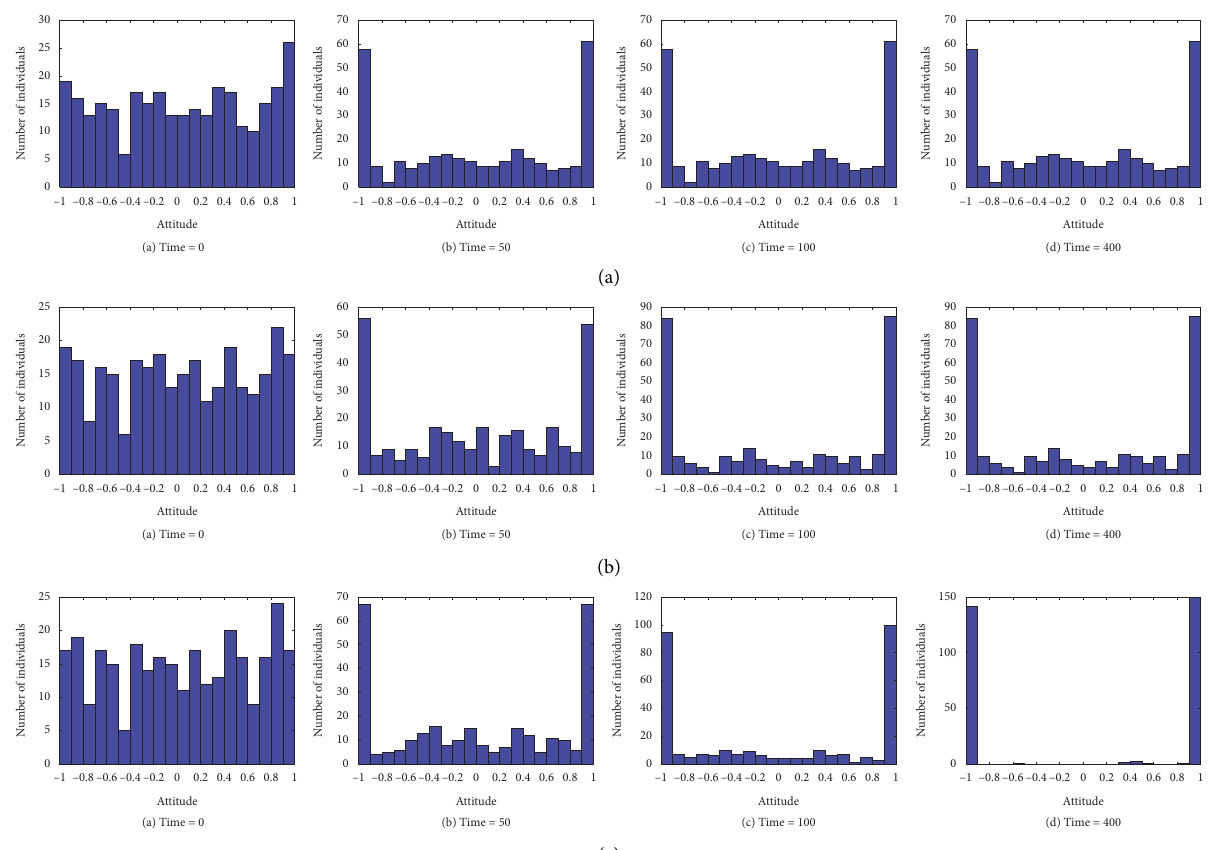
Figure 14: Histogram of individual attitude distribution under different interaction times corresponding to Figures 13(a)–13(c). (a) c � 0.1. (b) c � 0.3. (c) c � 0.5.